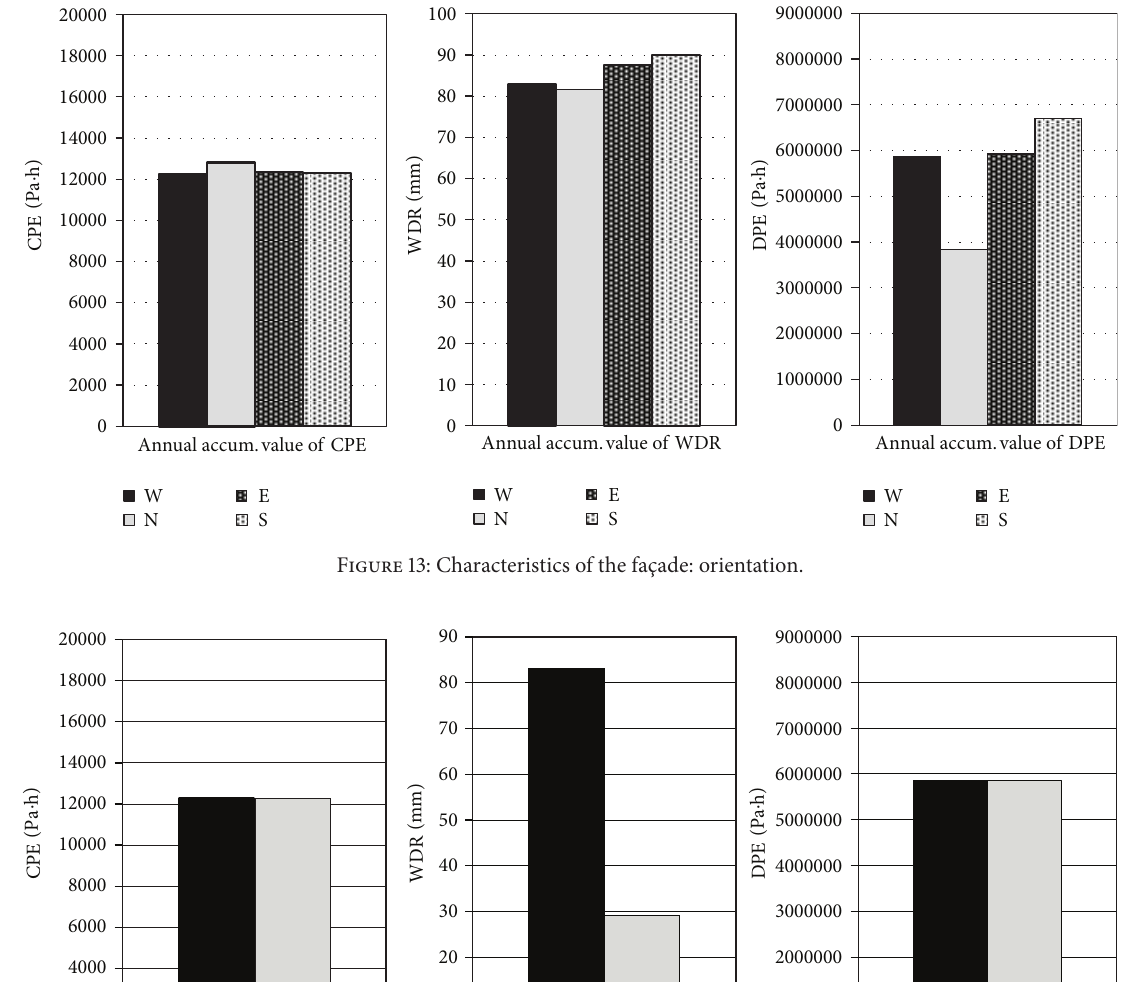
Figure 14: Characteristics of the fac¸ade: height of the